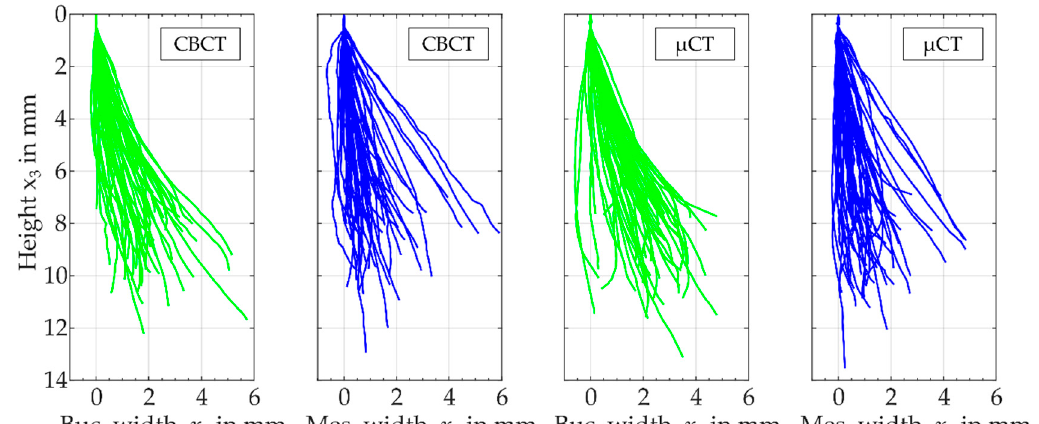
Figure 6. Buccolingual view and mesiodistal view of the filtered centre lines x i ( s ) evaluated from CBCT images and µCT images for all investigated root canals.